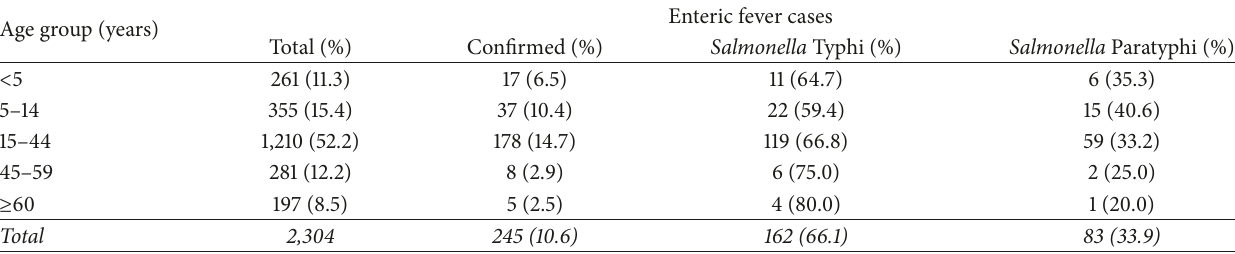
Table 1: Patients with enteric fever and their demographics.